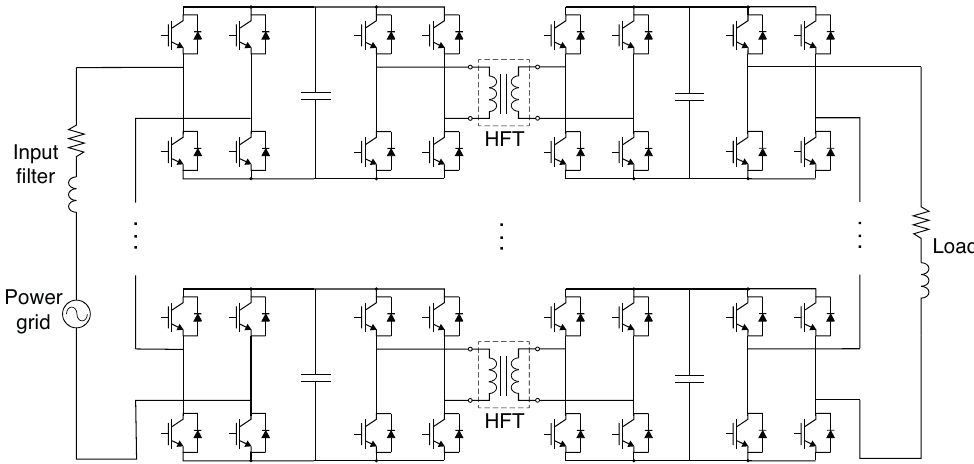
Figure 17. Three-stage SST formed by CHBCs in back-to-back configuration with DAB converters in the middle (adopted in